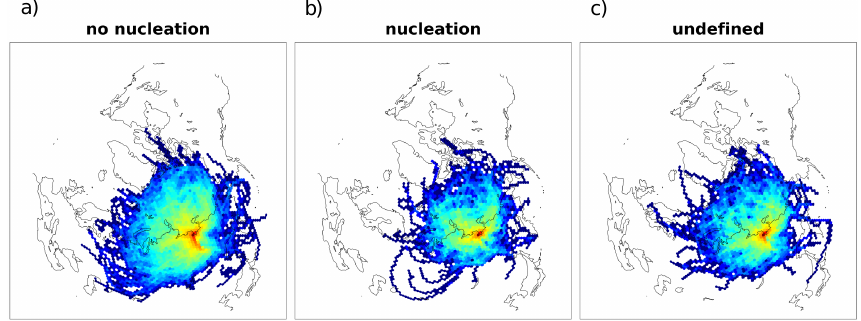
Figure 8. Back trajectories for air masses on non-event days (a) , at the start of the NPF events (b) , and at 11:00LT in undefined days (c) . Panels (a) , (b) , and (c) consist of 551, 259, and 244 individual trajectories, respectively. The trajectories were calculated using HYSPLIT 4 (Draxler and Hess, 1998) with an arrival height of 500m above ground level calculated 120h backwards in time. The color coding of the figure represents the number of trajectories that have passed over a geodesic hexagon on the map. Each trajectory coordinate was associated with a specific hexagon according to the minimum distance of a trajectory coordinate to the centroid of the grid cell. Each trajectory will pass over a number of grid cells. In order to circumvent weighting grid cells multiple times, each overpass is assigned only once to the grid cells that it will traverse.